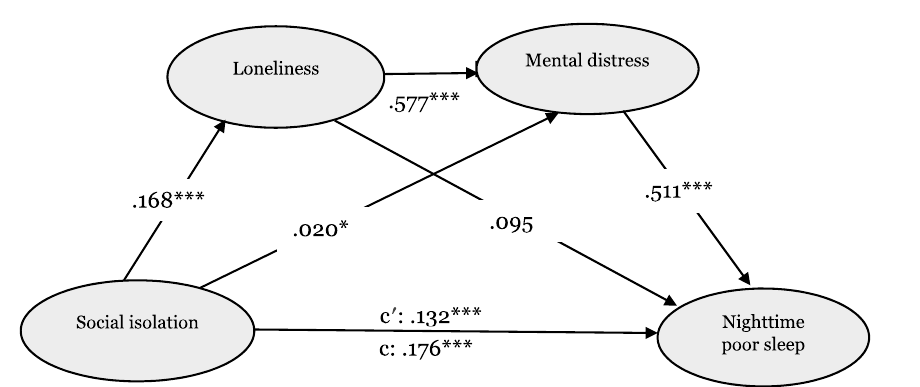
Figure 4. A serial multiple mediation model of the association between social isolation and experiencing nighttime poor sleep (e.g. falling asleep, waking up frequently during the night or waking up too early in the morning) through loneliness and mental distress. Path unstandardized coefficients are depicted. C ′ denotes the direct effect of social isolation on impaired sleep; c denotes the total effect of social isolation on impaired sleep via mediators. * p < 0.05, *** p <